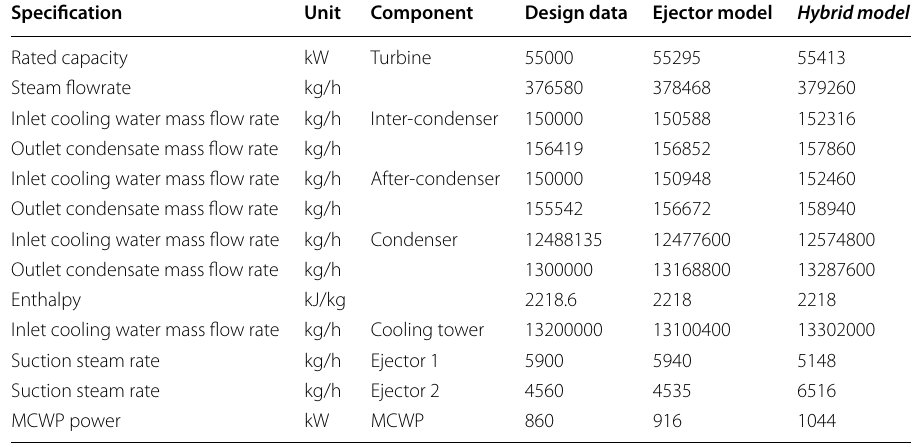
Table 2 Validation results of Kamojang GPP Units 2 and 3